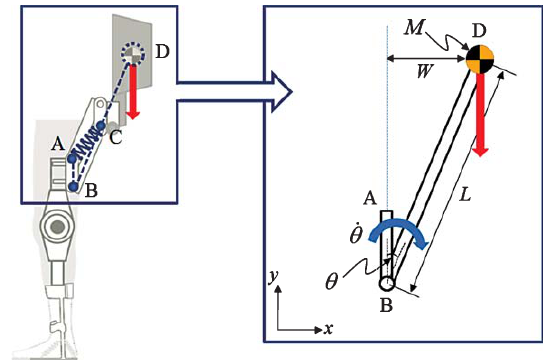
Fig. 7. Parameters of the WSM for the consideration of the weight balance